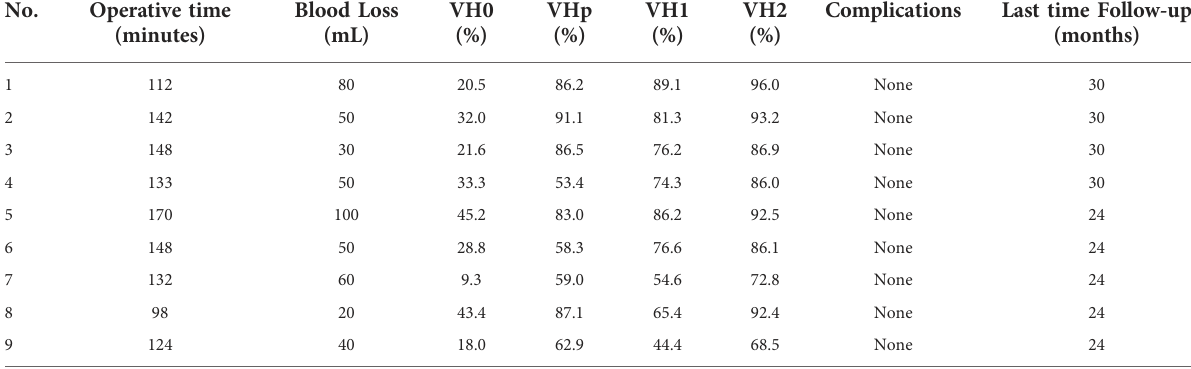
TABLE 2 Surgical details and follow-up features of BKP cohort.